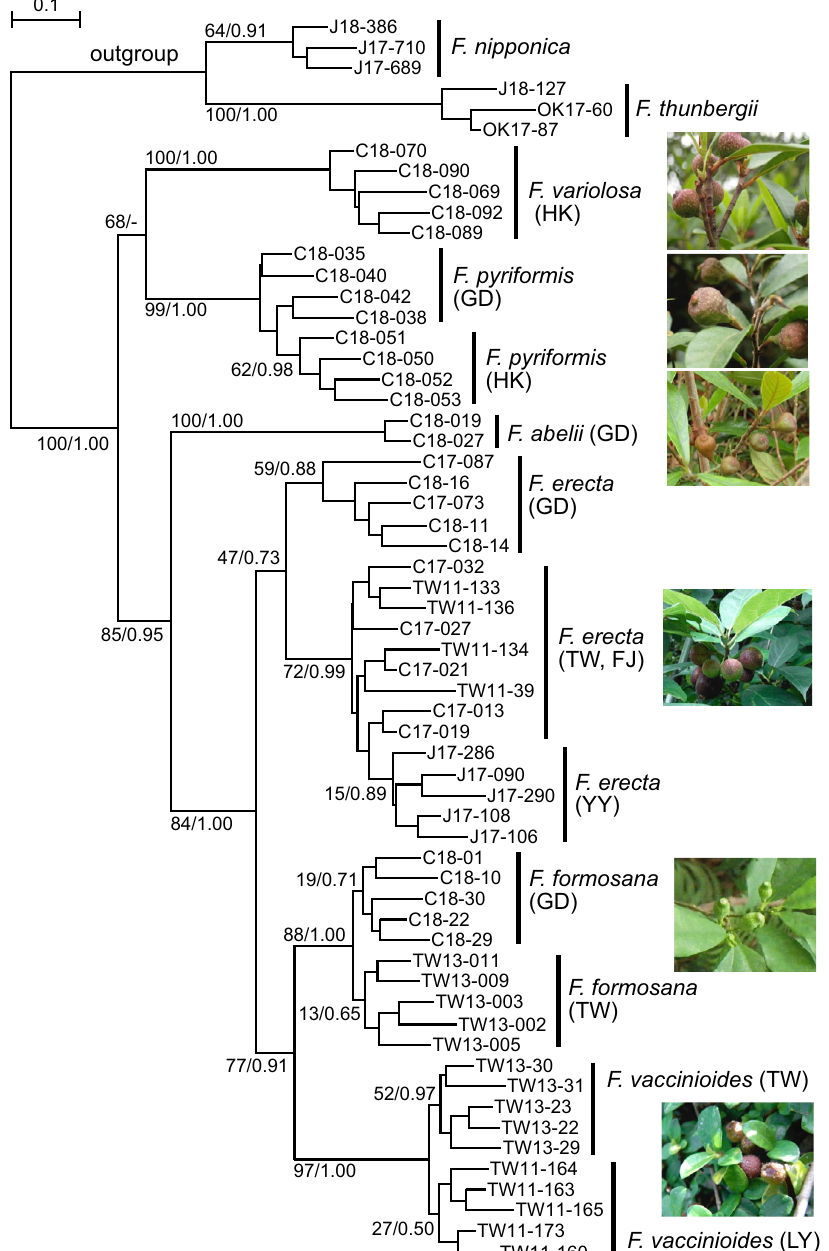
Fig. 2 Phylogenetic tree of six closely related fi g species based on genome-wide 2098 SNPs from 80138 loci of MIG-seq data. Ficus nipponica and F. thunbergii were used as outgroups for the phylogenetic analysis. The numbers at the nodes show ML bootstrap values and BI posterior probabilities. For sample information, refer to Table 1 and Supplementary Data 1. For the abbreviations of population names in parentheses, refer to Fig.